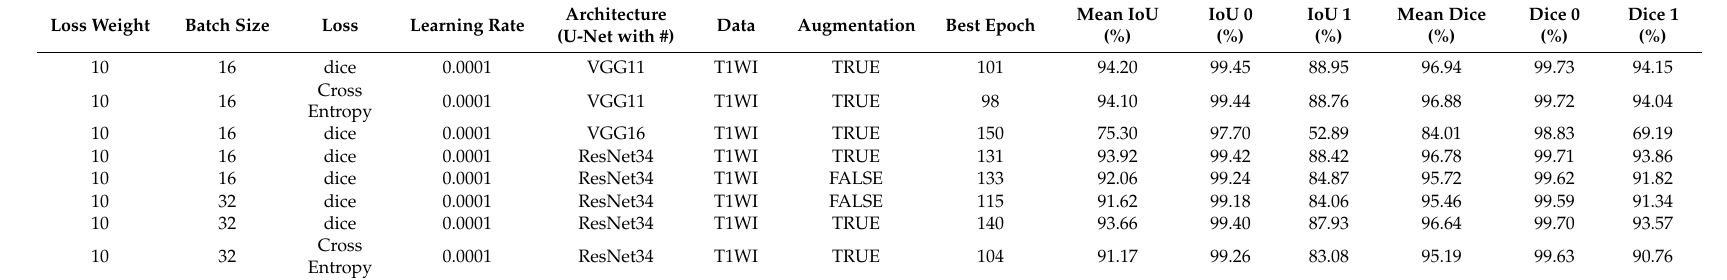
Table A4. Parameters and performance of all three architectures on “contrast-enhanced T1w” of the “uterus.”